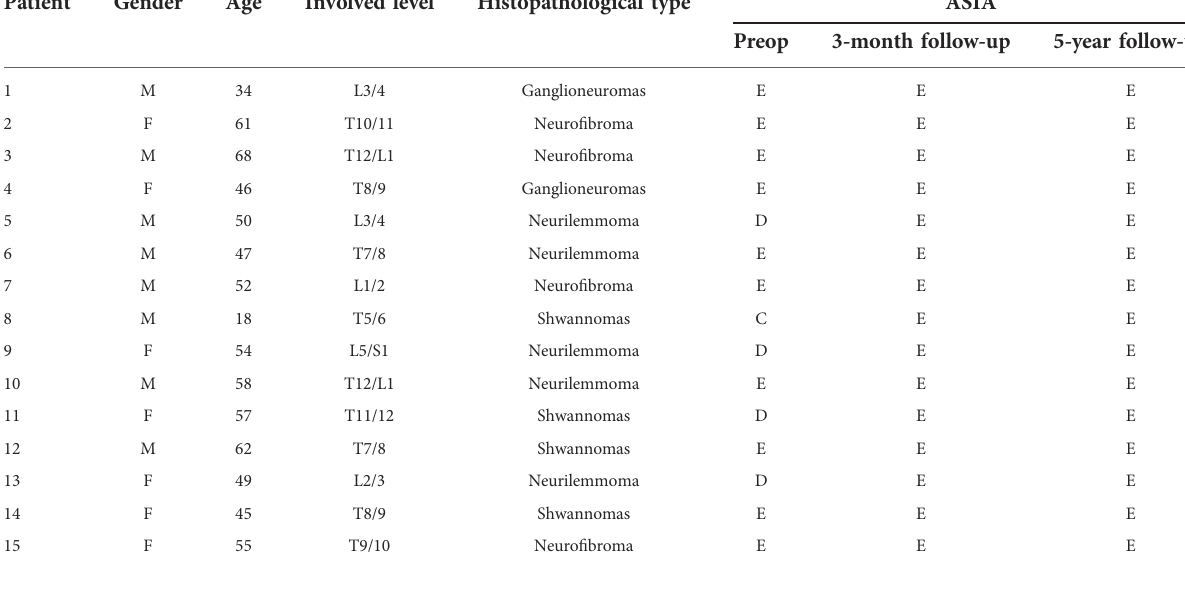
TABLE 1 Results of patients performed via the minimally invasive technique.